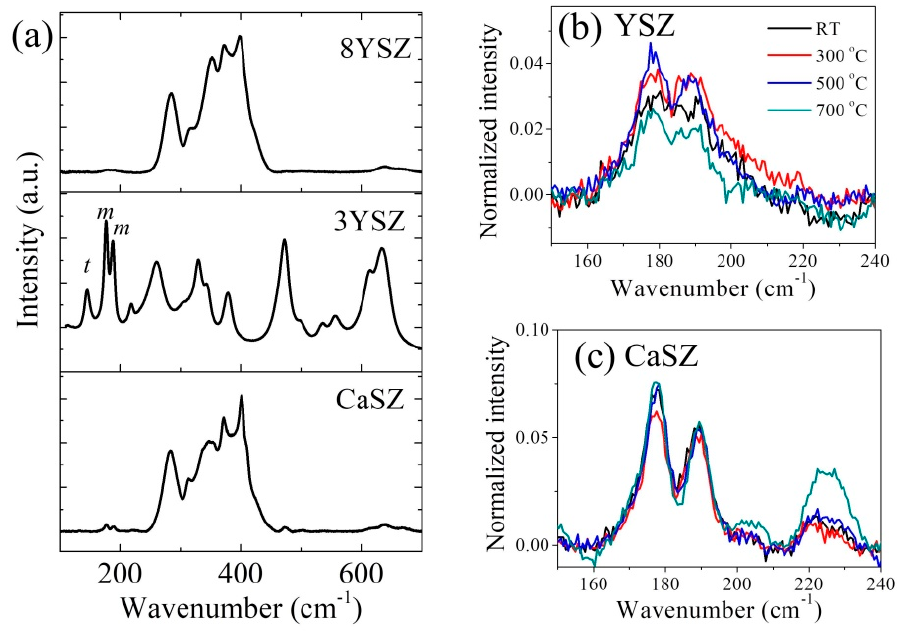
Figure 2. ( a ) Typical Raman spectra of the samples of YSZ (8 mol%), CaSZ and 3 mol% YSZ, and variations of Raman spectra in the range from 150 to 240 cm − 1 with annealing temperatures for ( b ) YSZ and ( c ) CaSZ.